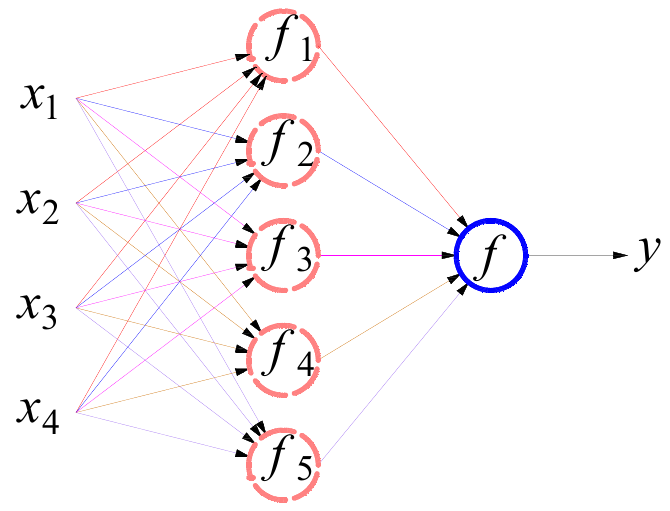
Figure 14. Process diagram of BP neural network.